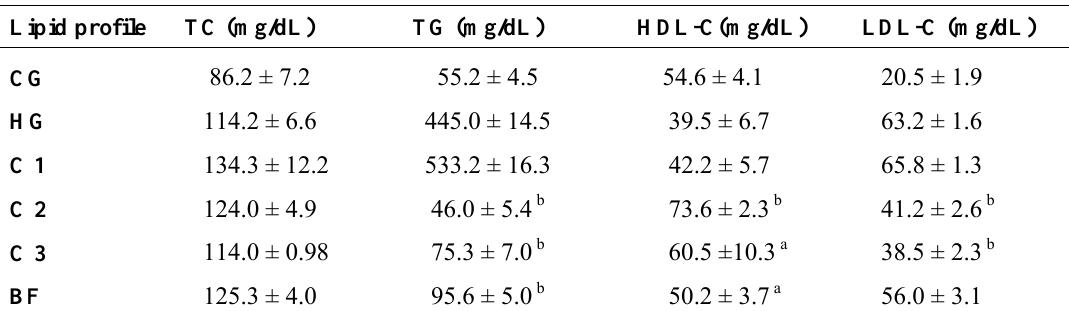
Table 1. Effect of the novel C1, C2, C3 and bezafibrate on plasma lipid levels in Triton WR-1339-induced hyperlipemic rats after 12